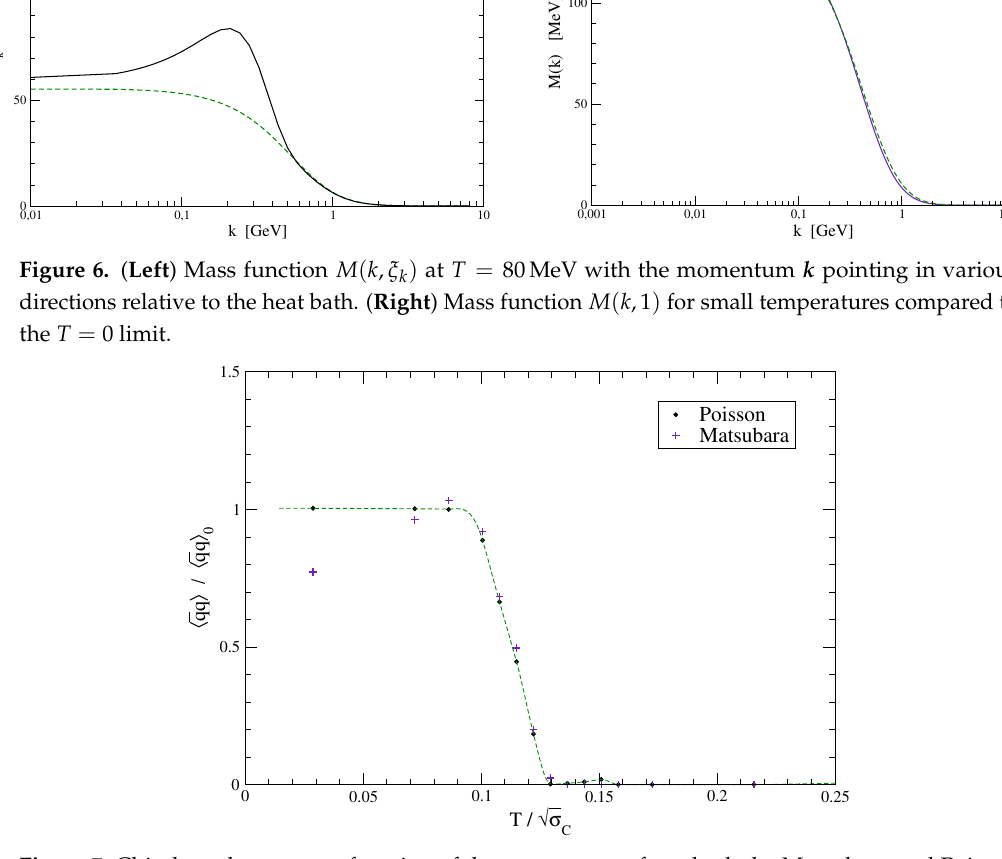
Figure 7. Chiral condensate as a function of the temperature, from both the Matsubara and Poisson formulations. To guide the eye, a dashed line was added through the Poisson data from which the critical temperature is